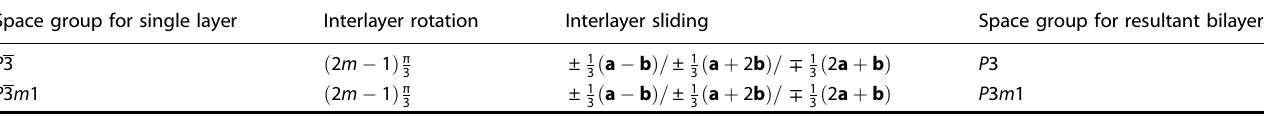
Table 1. Design principle of spontaneous valley polarization based on two centrosymmetric space